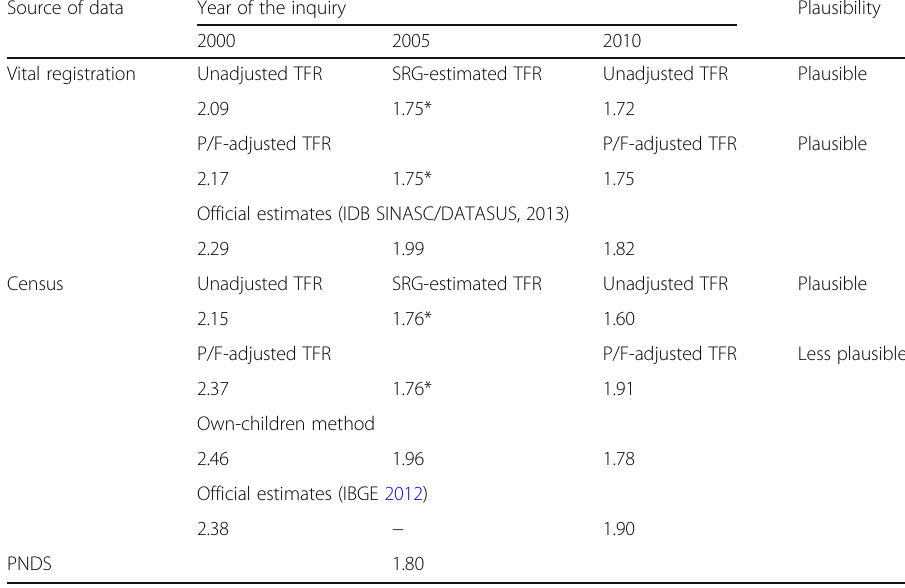
Table 1 Comparison between TFRs according to different data sources and estimates, Brazil, 2000 – 2010